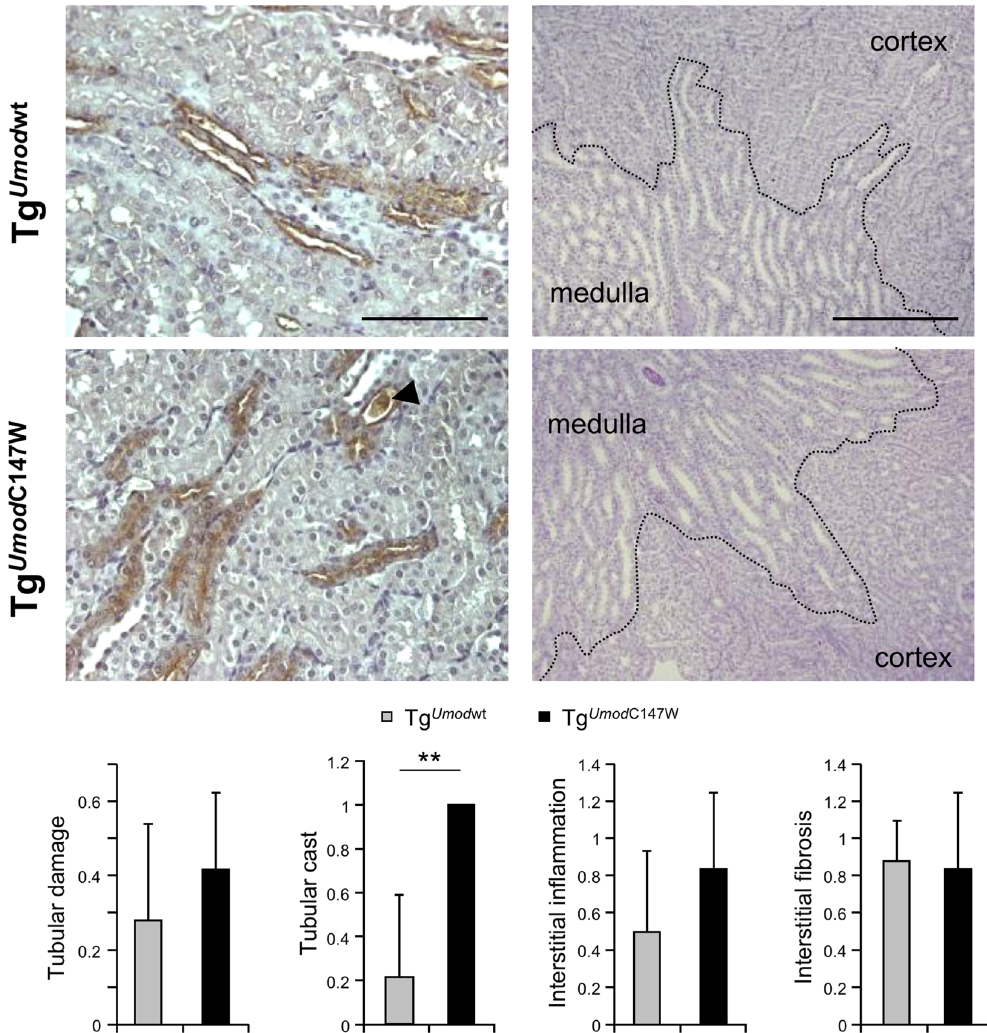
Figure 1. Representative images of kidneys from 1 month-old Tg Umod C147W and Tg Umod wt mice. Immunohistochemistry analysis for total uromodulin shows that the protein is mainly distributed at the apical membrane of TAL cells in Tg Umod wt mice, while it is intracellularly enriched in Tg Umod C147W mice (left panels, scale bar 100 µ m). Representative images of kidney sections (right panels, PAS, scale bar 200 µ m) and quantification of histological parameters (bottom) are shown. Data are expressed as mean ± s.d. (n = 9 Tg Umod wt and 6 Tg Umod C147W ). Tg Umod C147W mice show a relatively well preserved kidney structure. Only tubular casts, mostly uromodulin-positive (left panel, arrowhead) resulted to be increased. ** P < 0.01 (Mann-Whitney